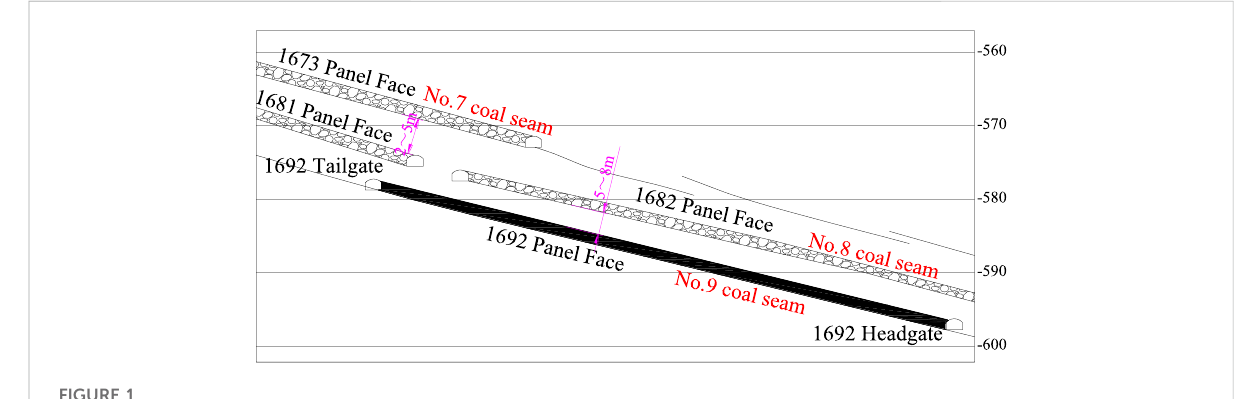
FIGURE 1 Distribution of the ultra-multiple coal